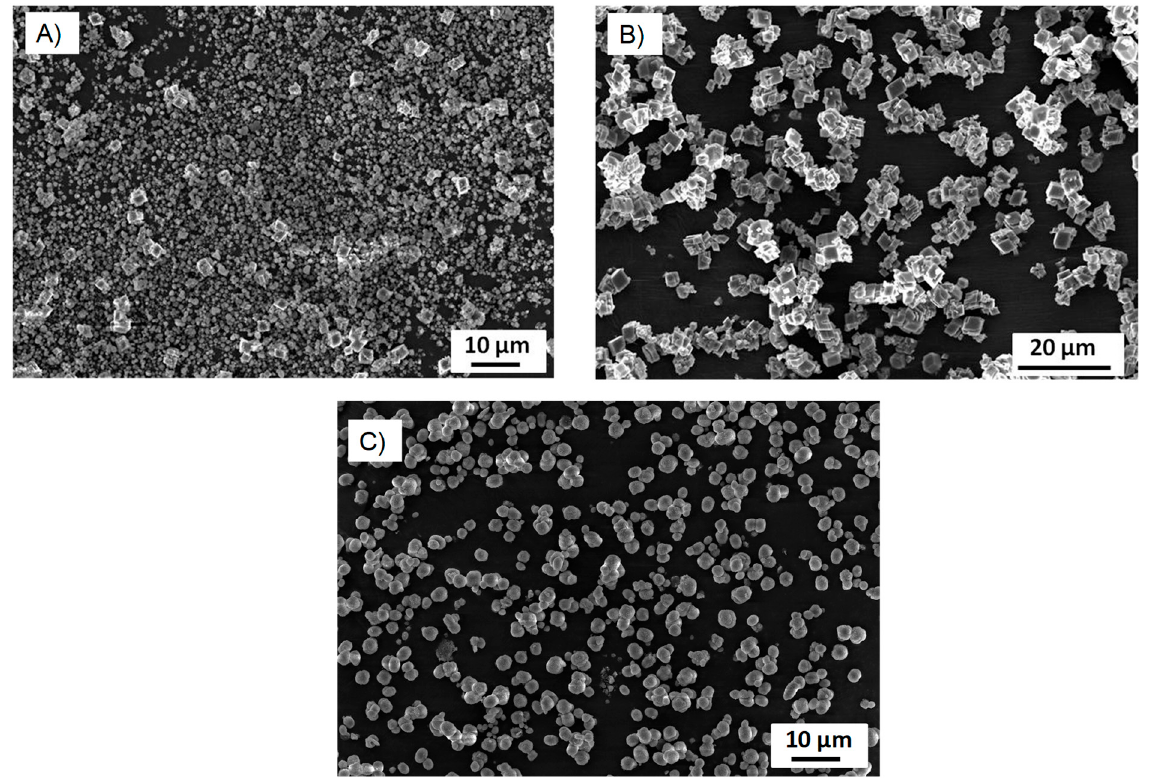
Figure 7. Scanning electron microscopy image ( A ) CD-glycerol_4mM_10min, ( B ) CD-glycerol_4mM_4h and ( C ) CD-glycerol_1mM_4h.